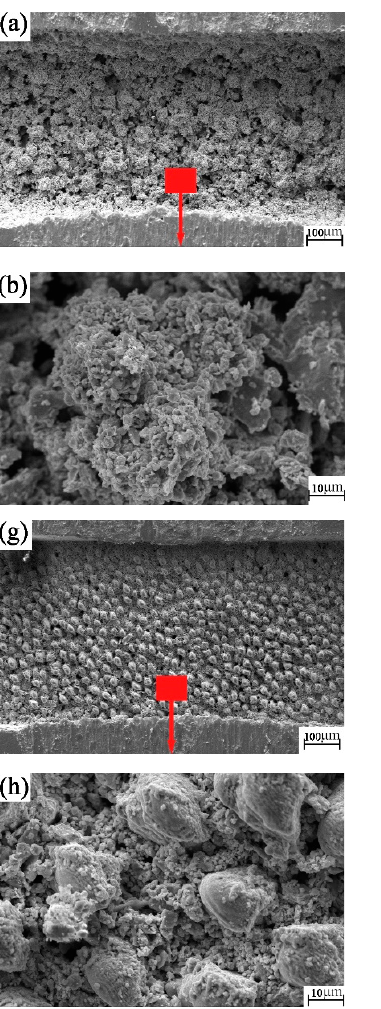
Figure 9. SEM images of the picosecond textured worn balls: ( a – c ) rotation radius 15 mm; ( d – f ) rotation radius 18 mm and ( g – i ) rotation radius 22.5 mm.